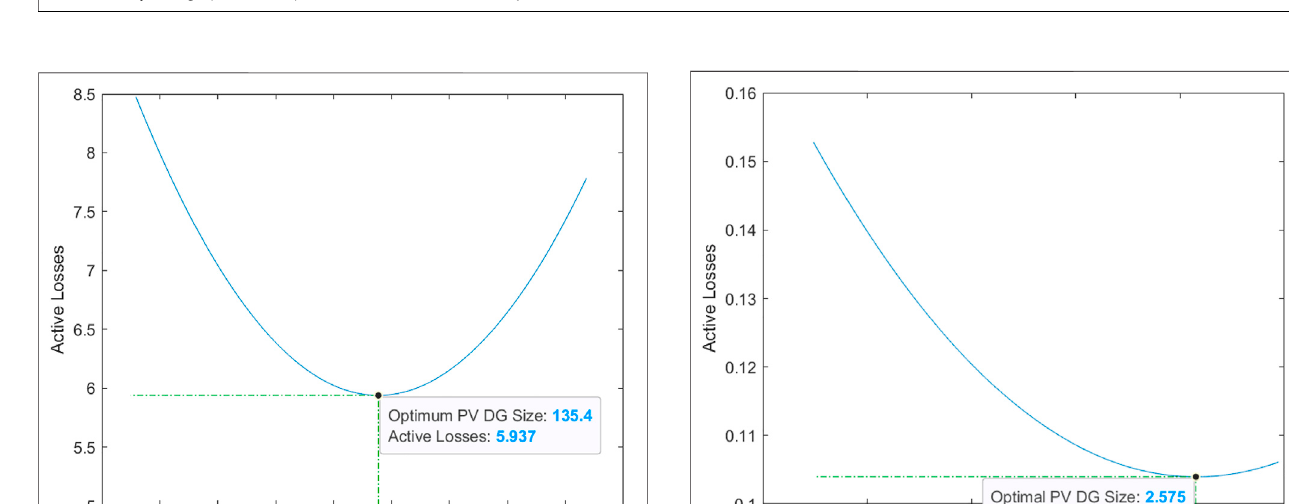
FIGURE 8 | Voltage pro fi le comparison for the IEEE 33 bus system.